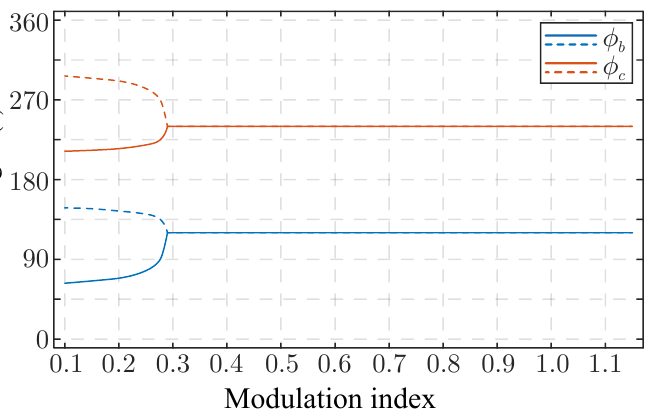
Figure 8. Carrier phase-displacement angles to achieve the minimization of the CMV THD in a modulation index range from 0.1 to